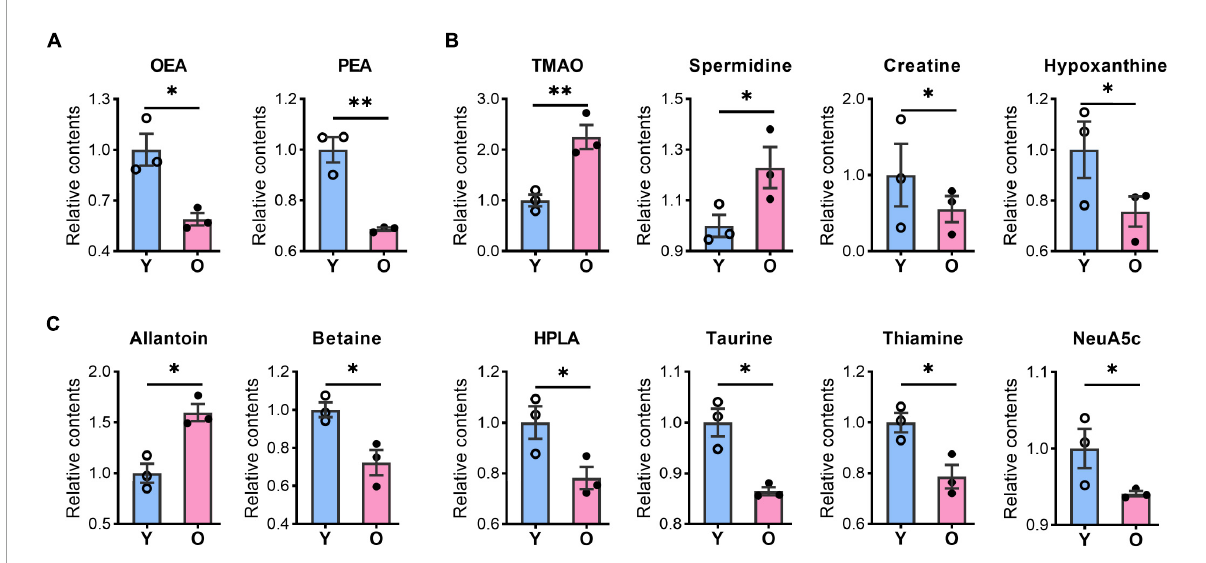
FIGURE4 The contents of bioactive lipids and microbiota-derived metabolites were changed in the aged hippocampus of male mice. The relative contents of bioactive lipids, OEA, and PEA (A) ; microbiota-derived metabolites, TMAO, spermidine, creatine, and hypoxanthine (B) , allantoin, betaine, HPLA, taurine, thiamine, and Neu5Ac (C) were altered in the aged (O) and young (Y) hippocampus. Data are calculated as the relative contents of the young group and represent the means ± SEM. Student’s t -test, n = 3 per group, ∗ p < 0.05, ∗∗ p < 0.01). OEA, N-oleoylethanolamine; PEA, palmitoylethanolamide; TMAO, trimethylamine N-oxide; HPLA, hydroxyphenyl lactic acid; Neu5Ac, N-acetylneuraminic